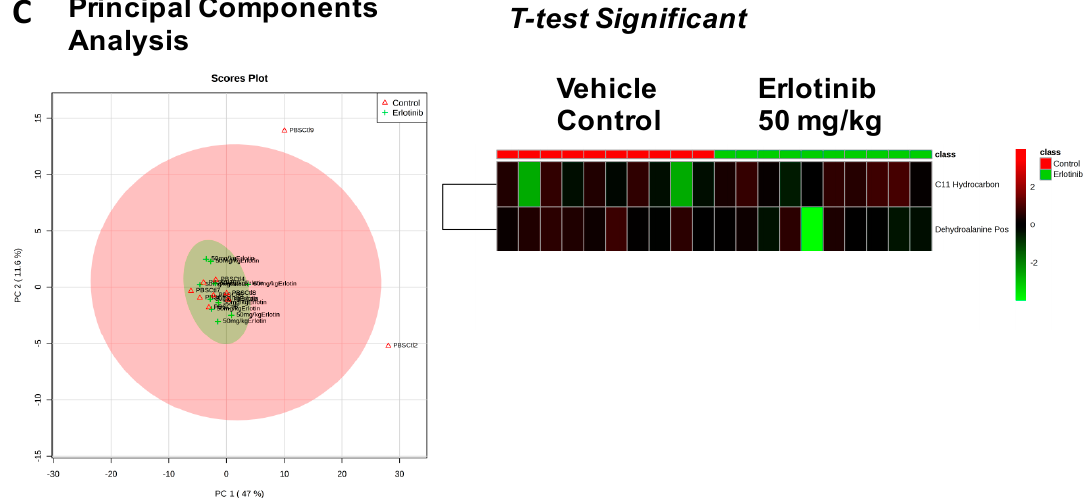
Figure 4. Significant metabolites identified in skeletal muscle 2 weeks after tyrosine kinase inhibitor (or vehicle control) treatment. PCA (principal components analysis) of metabolites identified in quadriceps femoris after sunitinib treatment ( A ). t -test significant metabolites identified in quadriceps femoris after sunitinib treatment ( B ). PCA (principal components analysis) of metabolites identified in quadriceps femoris after erlotinib treatment ( C ). t -test significant metabolites identified in quadriceps femoris after erlotinib treatment ( D ). N = 10/group